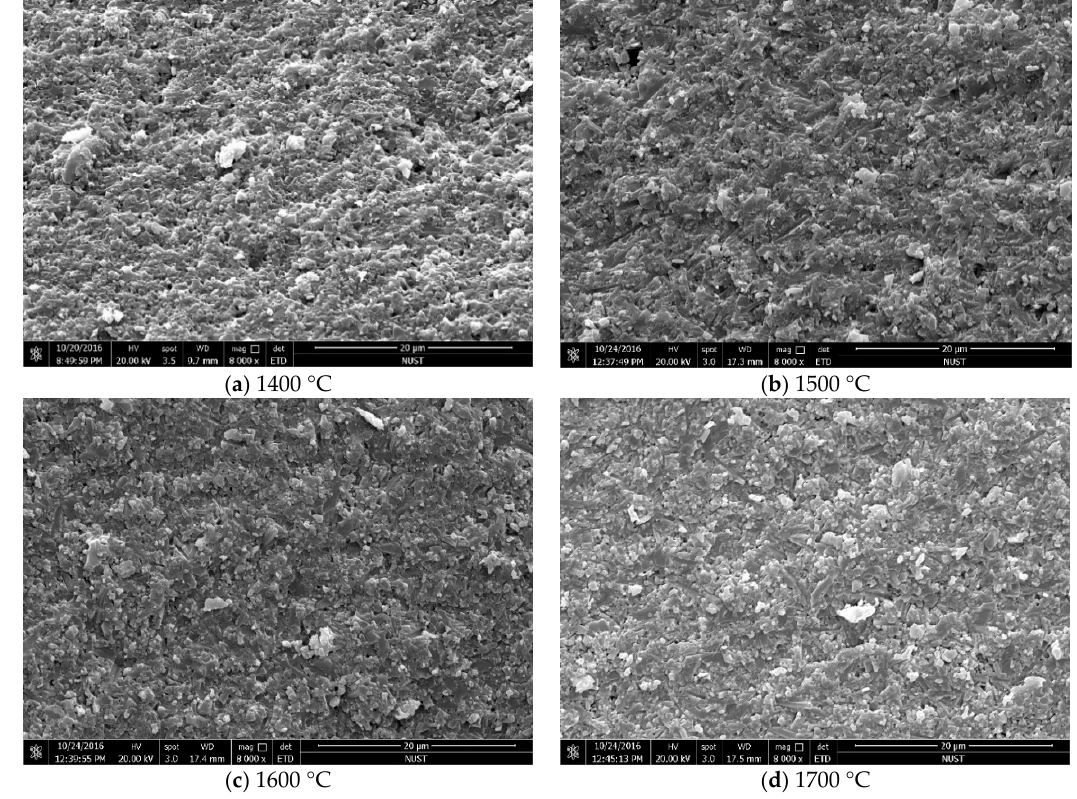
Figure 3. The Scanning electron microscopy (SEM) micrographs of the fracture surface of the sintered Si 3 N 4 /n-SiC ceramics at different sintering temperatures (holding time for 10 min).